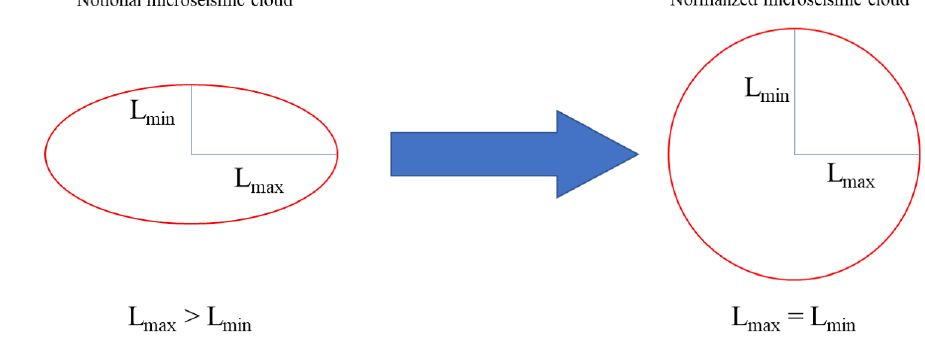
Figure 1. Applying the normalisation method by [44] on a notional stimulated rock volume (SRV) microseismic cloud. The notional microseismic cloud is assumed to be within anisotropic 2-dimensional ellipse. After normalisation, the microseismic cloud can be bounded with a circular shape reducing the analysis to a 1-dimensional